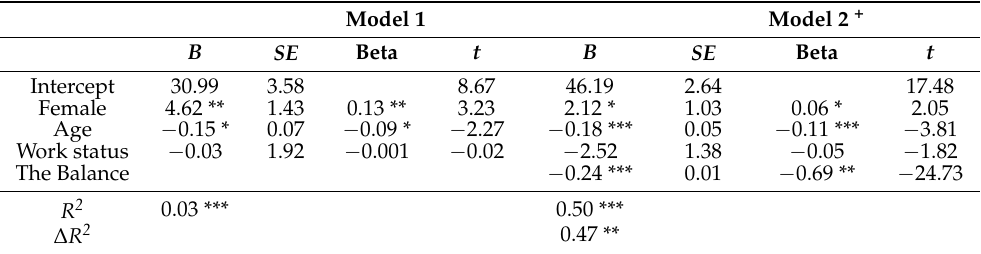
Table 3. Regression coefficients for models testing the effects of demographic variables of age, gender, work status and risk and protective factors on participant’s job burnout